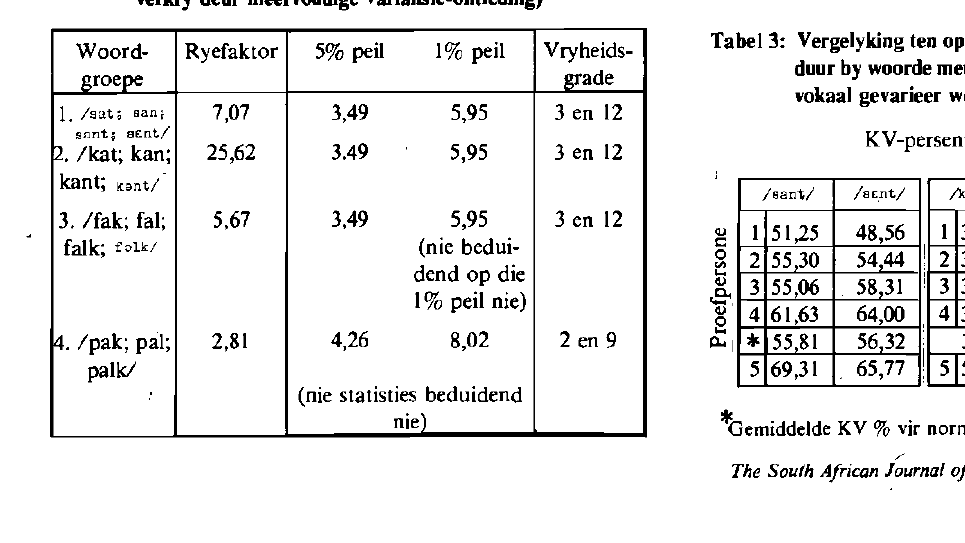
Tabel 3: Vergelyking ten opsigte van KV as persentasie van totale duur by woorde met dieselfde samestelling, waar slegs die vokaal gevarieer word KV-persentasie (van die